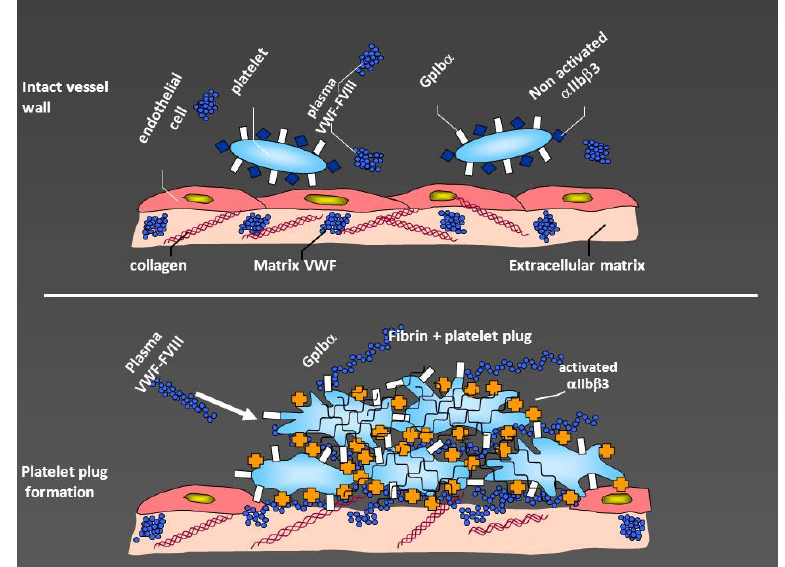
Figure 1. The role of von Willebrand factor (VWF) in hemostasis. After vessel injury, subendothelium becomes exposed with collagen and VWF contained in the subendothelial matrix. The interaction of von Willebrand factor with glycoprotein Ib α (GpIb α ), naturally exposed on the platelet surface, creates initial adhesion of platelets to the subendothelium and platelet activation. This makes the platelets to expose glycoprotein IIb/IIIa ( α IIb β 3) which binds fibrinogen and VWF thus, increasing platelet plug. Factor VIII is bound to VWF and is naturally conveyed to the site of lesion, thus allowing also the generation of adequate amounts of fibrin (modified by courtesy of AB Federici). Table 1. Classification of von Willebrand disease, modified from Sadler et al. 2006 [15].